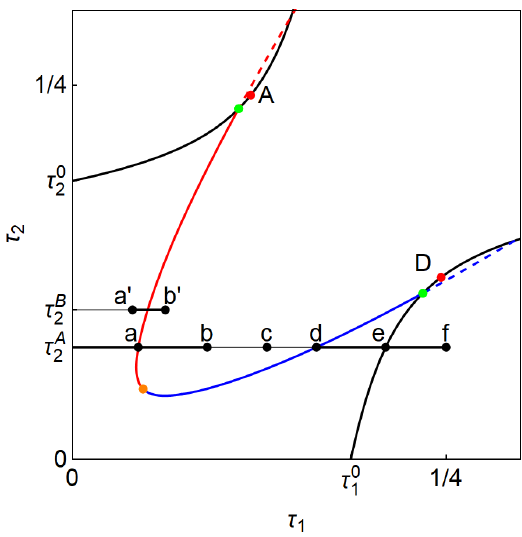
Figure 8. The stability switching curve for α = 10 and σ = 0.1.